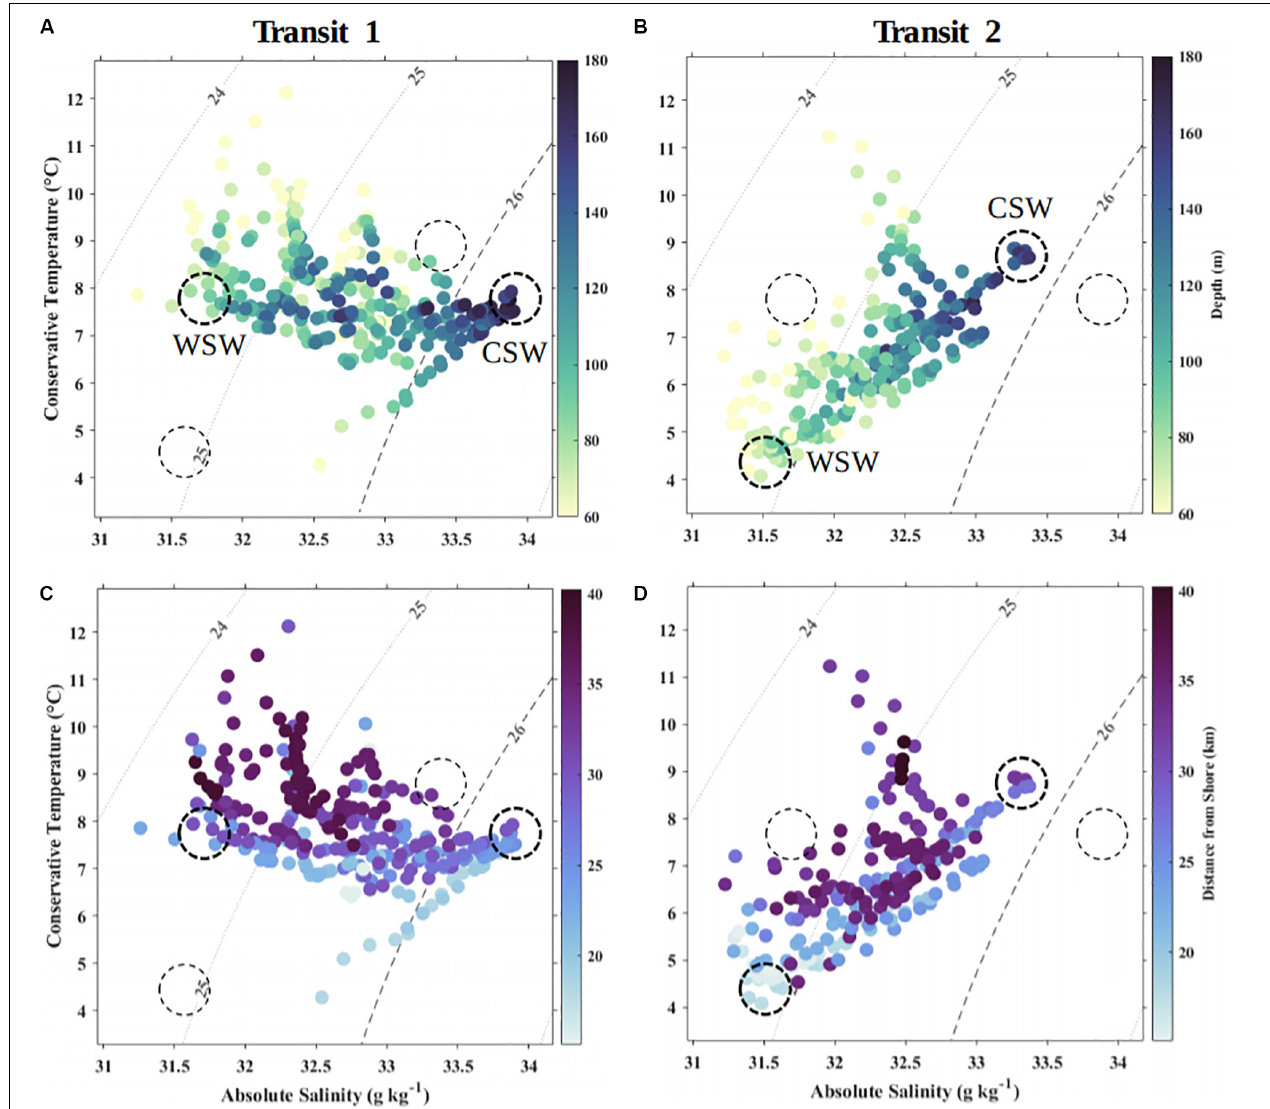
FIGURE 5 | Temperature-salinity diagrams showing variation in seafloor depth (A,B) and across-shelf distance (C,D) between transit 1, September–October 2015 (A,C) , and transit 2, October–November 2015 (B,D) . Data are daily averages over 10 m vertical bins. Basin sill depth is approximately at the 100 m isobath. Data from depths < 60 m are not shown to remove the seasonal atmospheric cooling signal. Water masses referred to in text (WSW and CSW) are indicated with dashed circles; bold dashes indicate the endmembers for the transit